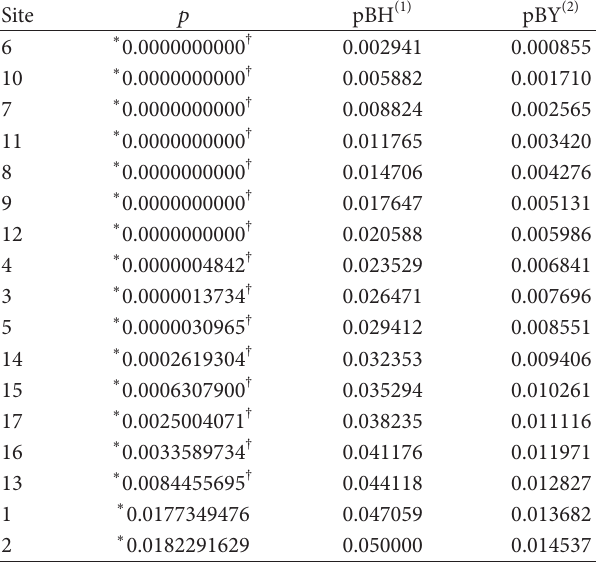
T 8: Evaluating statistical signi�cance of individual sites by two types of false discovery